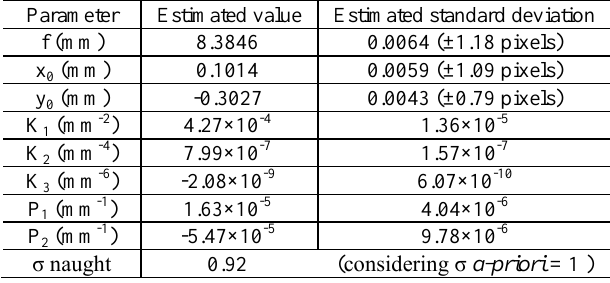
Table 1. IOPs estimated by the camera calibration using bundle adjustment with the equidistant model.